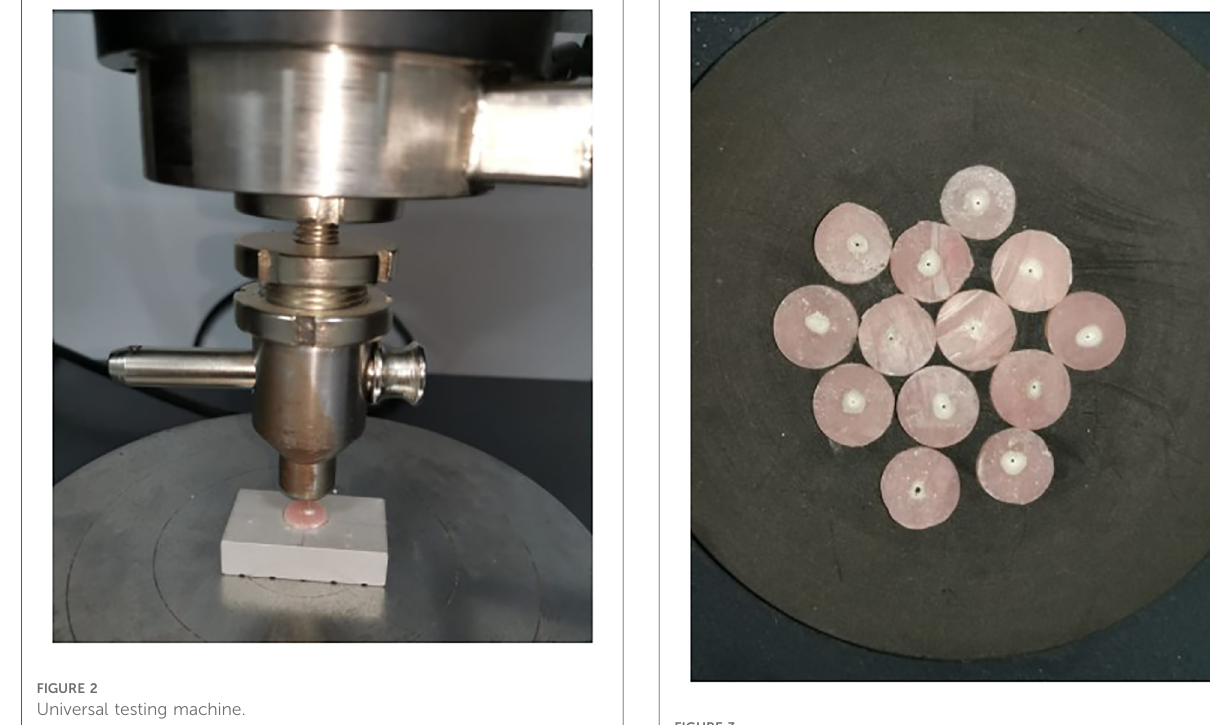
FIGURE 3 Dentin discs after force is